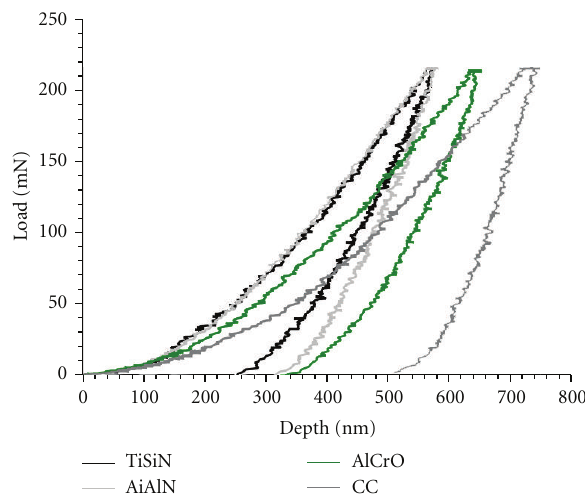
Figure 3: Indentation load-displacement curves obtained for the uncoated and the PVD coated cemented carbide substrates